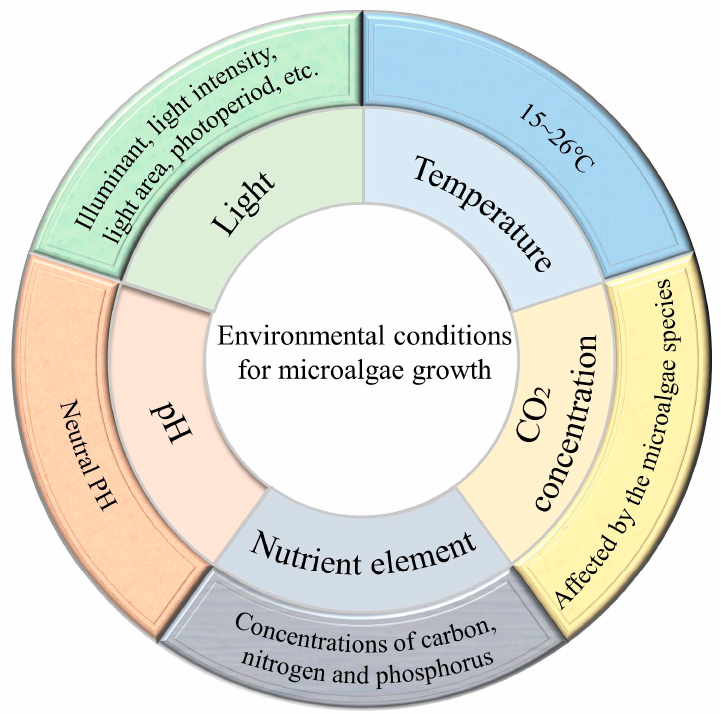
Figure 4. Different growth environment conditions affect the growth rate of